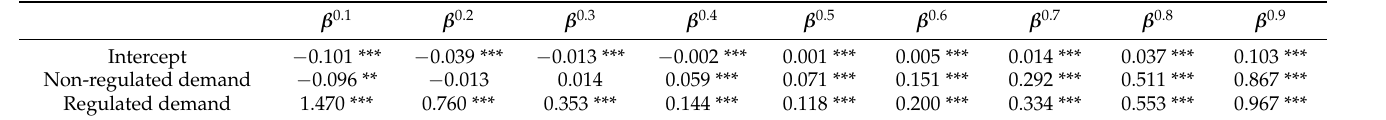
Table A2. Quantile regression coefficients for different quantiles in 2019.